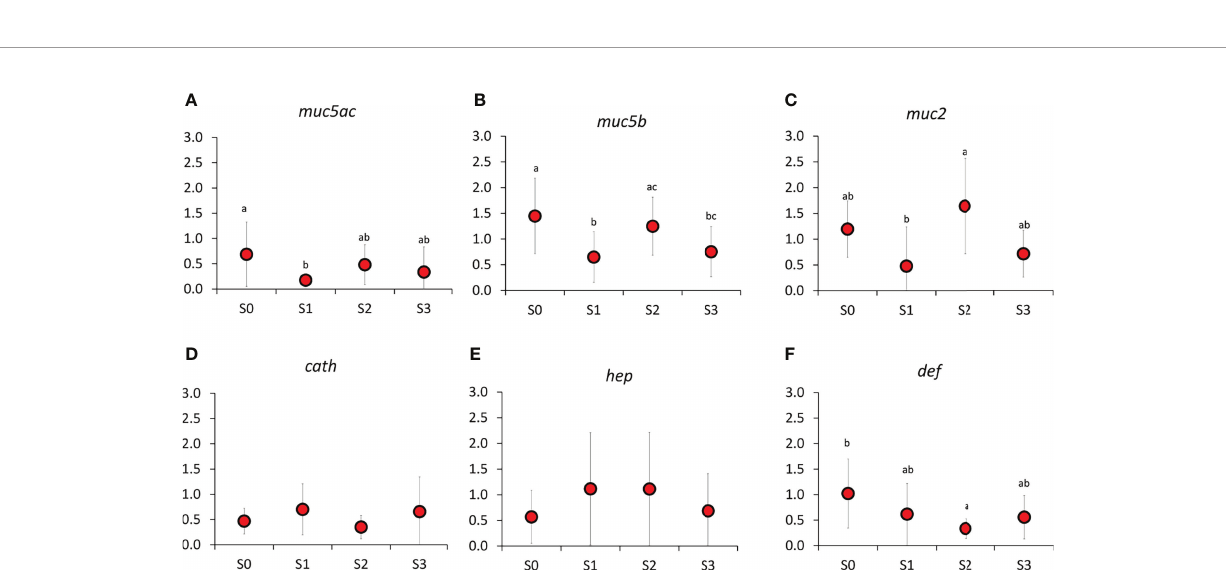
FIGURE 7 | Expression of key genes important for (A – G) epithelial integrity and (H, I) stress response in the skin. Different letters indicate a signi fi cant difference at < 0.05, analyzed by ANOVA followed by a Holm – Sidak post-hoc test. Values are presented as mean ± SD of 15 individual fi sh (N=15) per sampling point.